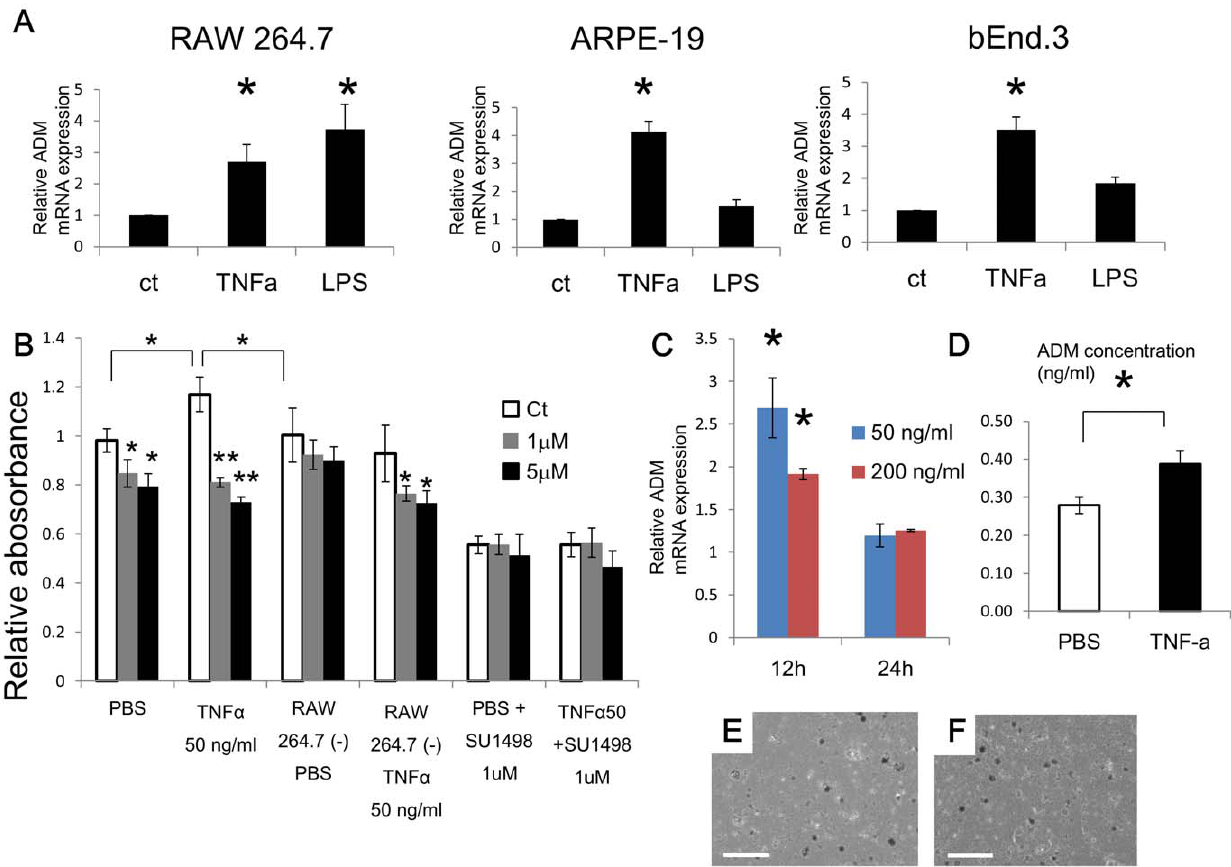
Figure 3. In vitro effect of an ADM antagonist. (A) qRT–PCR analysis of ADM mRNA expression after 12 h r TNF- a or LPS stimulation of cells, as indicated (n=3, *P , 0.01). (B) EC proliferation assay using bEND.3 which was incubated with or without supernatant from TNF- a -stimulated RAW 264.7 in the presence or absence of the ADM antagonist ADM (22–52). The white bar indicates the PBS group, gray indicates the 1 m M ADM (22–52) group and black the 5 m M ADM (22–52) group. ECs in all groups were incubated with supernatant from RAW 264.7 cells except for RAW 264.7 (-) groups (culture medium without supernatant of RAW 264.7 cells). 1 m M SU1498 was added to indicated groups (n=3, **P , 0.01, *P , 0.05). (C) qRT– PCR analysis of ADM mRNA expression after 12 and 24 hr TNF- a stimulation of primary RPE/choroid cultures (n=3, *P , 0.05). (D) ELISA of secreted ADM from primary RPE/choroid cultures after stimulation with 50 ng/ml TNF- a or culture with PBS alone (*P , 0.05) (E, F) Appearance of primary RPE/ choroid cultures after stimulation with PBS (E) or 50 ng/ml TNF- a (F). Scale bar: 100 m